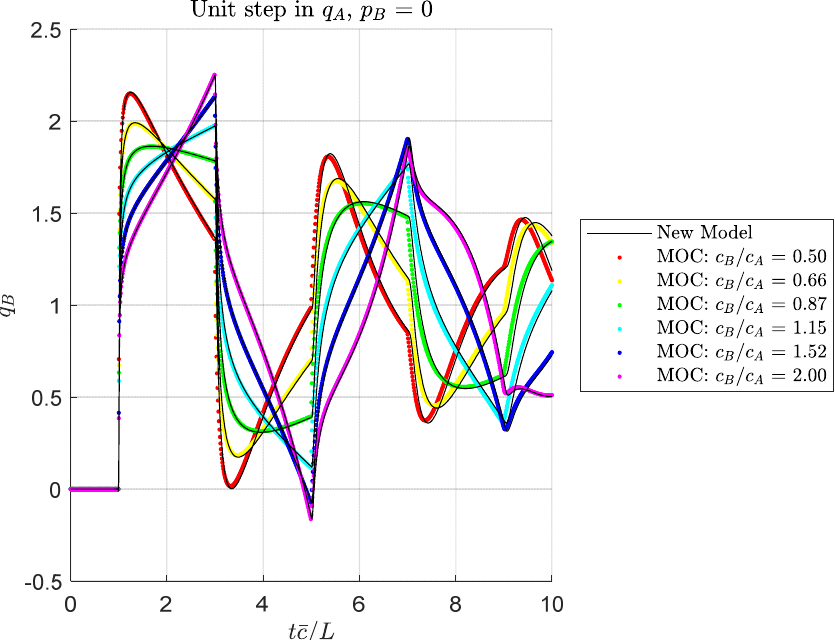
Figure 6. Outlet flow response to a unit step in inlet flow, for an open exit, showing effect of taper ratio.